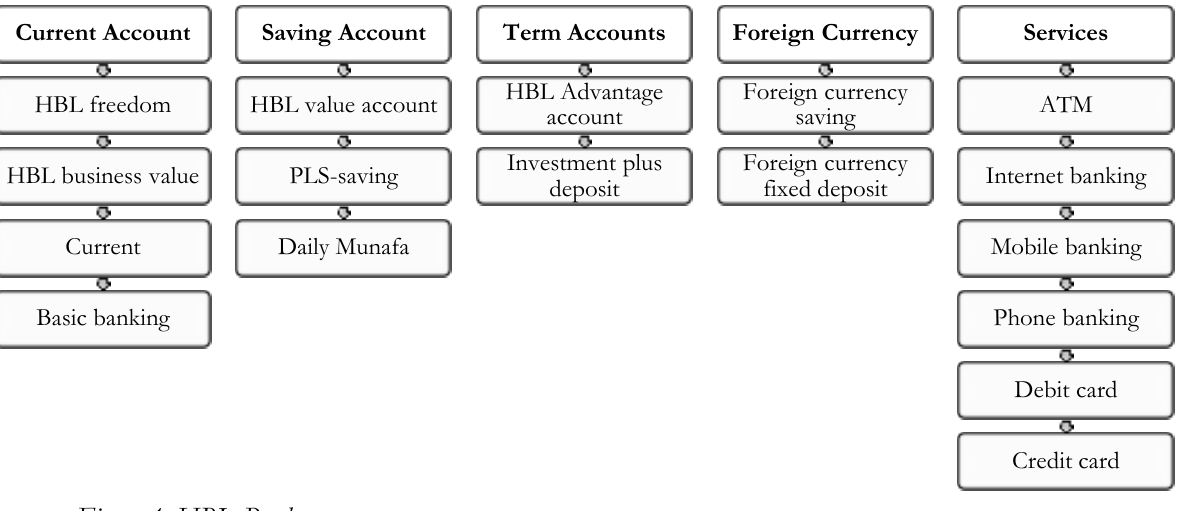
Figure 4: HBL Products